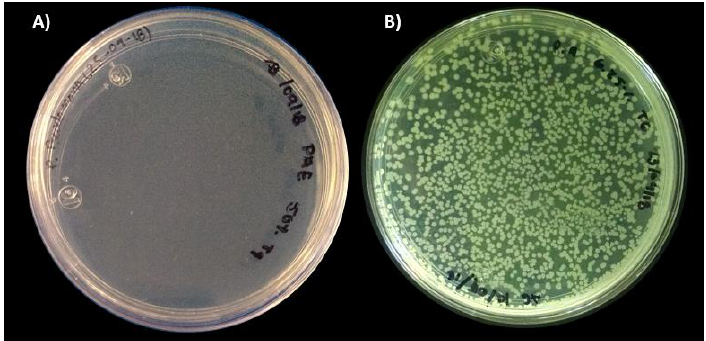
Figure 5. P. aeruginosa (ATCC 27853) cultures cultivated with silver nanoparticles at concentrations of ( A ) 0.72 μg/mL and ( B ) 0.02 μg/mL after 4 h.